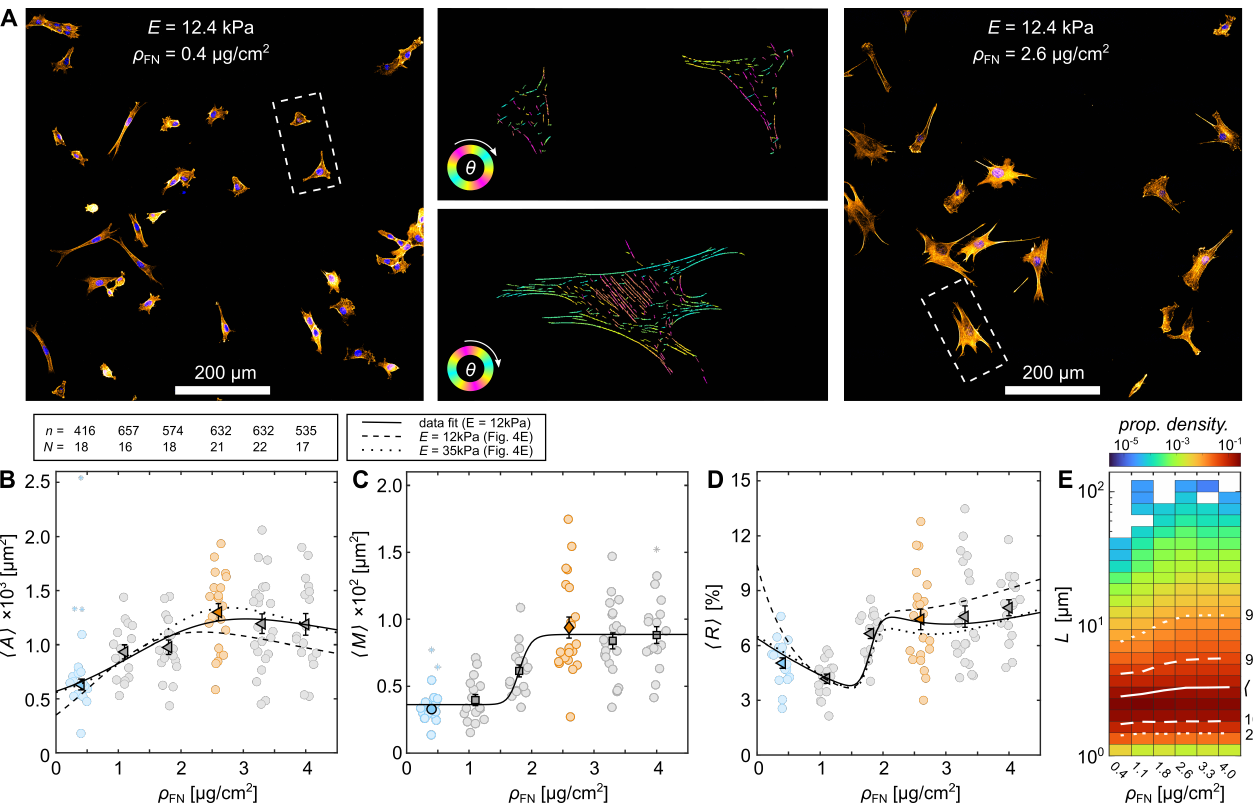
Figure 5. Actin cytoskeleton formation dependence on fibronectin density. ( A ) Actin- and cell-nuclei- labeled confocal images of C2C12 cells on E (cid:39) 12.4 kPa hydrogels coated with ρ FN (cid:39) 0.4 µ g/cm 2 ( left panel) and ρ FN (cid:39) 2.6 µ g/cm 2 ( right panel). Two exemplary sections of prior-processed images by AQuA ( middle panel) are illustrated from these two ρ FN (dashed selection, left and right panel). ( B – D ) Statistical analysis of mean projected cell areas (cid:104) A (cid:105) , mean amount of actin (cid:104) M (cid:105) , and fraction of actin amount to cell area (cid:104) R (cid:105) of the 5 × 5 tiled images. The respective number of images N and sum of the containing cells, i.e., nuclei, n is written on top of ( B ). Each brightly colored round data point is calculated from one 5 × 5 tiled image, and the mean and standard error of those are shown by the darker-colored data points. Substrates functionalized with ρ FN (cid:39) 0.4 µ g/cm 2 and ρ FN (cid:39) 2.6 µ g/cm 2 are highlighted in blue and orange. Asterisks depict outliers (see Section 2). ( E ) Probability density of actin fiber length L . Percentiles of 2%, 10%, 90% and 98% are marked by dashed and dotted white lines. (cid:104) L (cid:105) is marked as a solid white